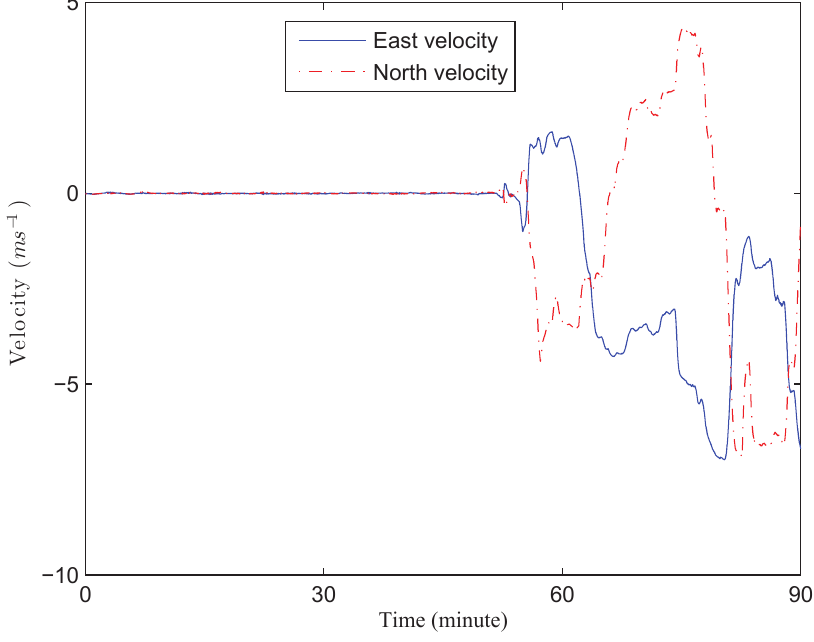
Figure 7. Real velocities of this field